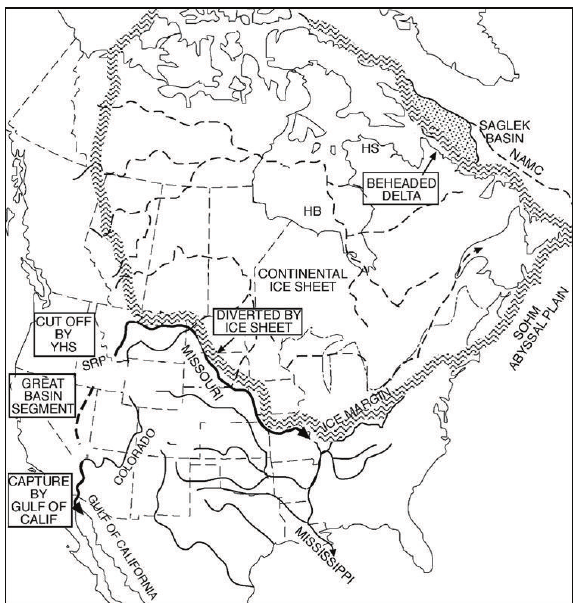
Figure 6: Maximum extent of the last Pleistocene glaciation in North America. Modified from